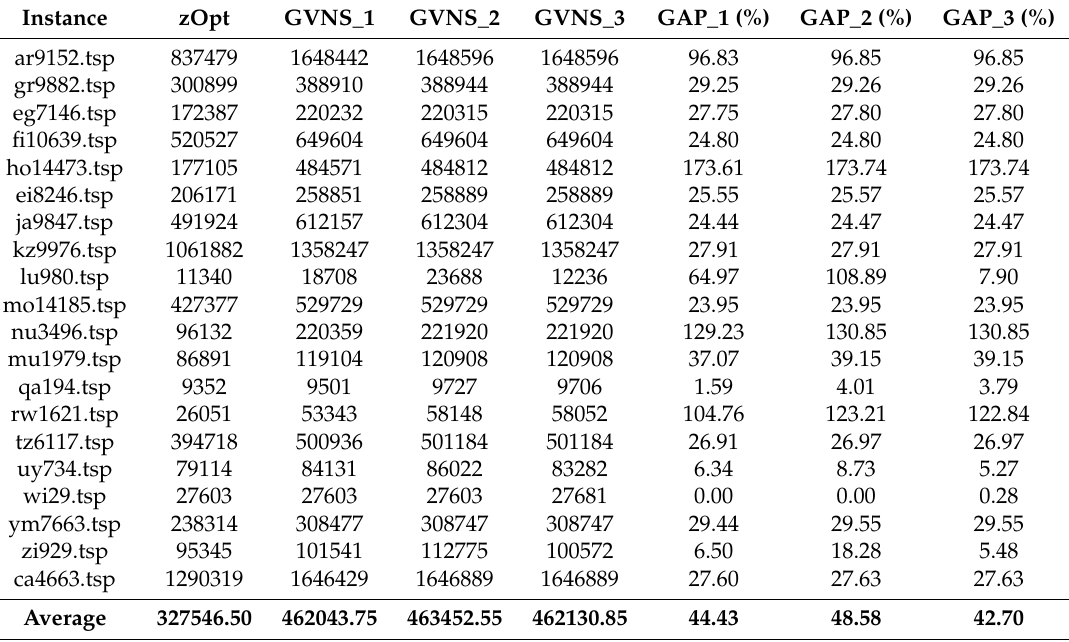
Table 9. Results using the First Improvement search strategy and an execution time limit of 1